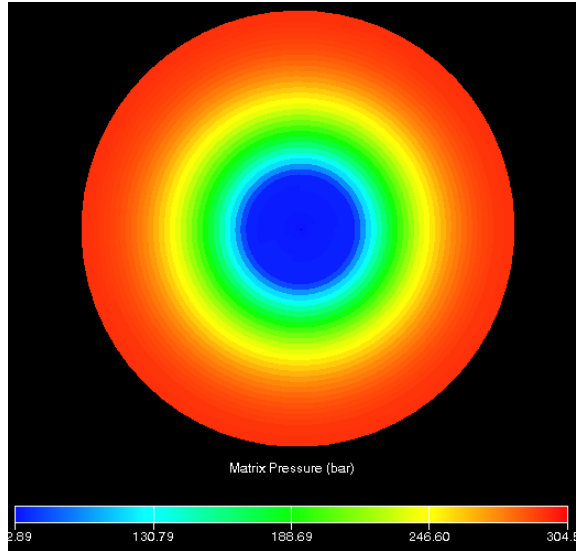
Figure 2. Comparison of cumulative gas production of model in this paper and the Eclipse numerical model.